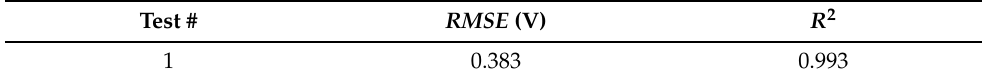
Table 5. Battery Parameter Identification Voltage